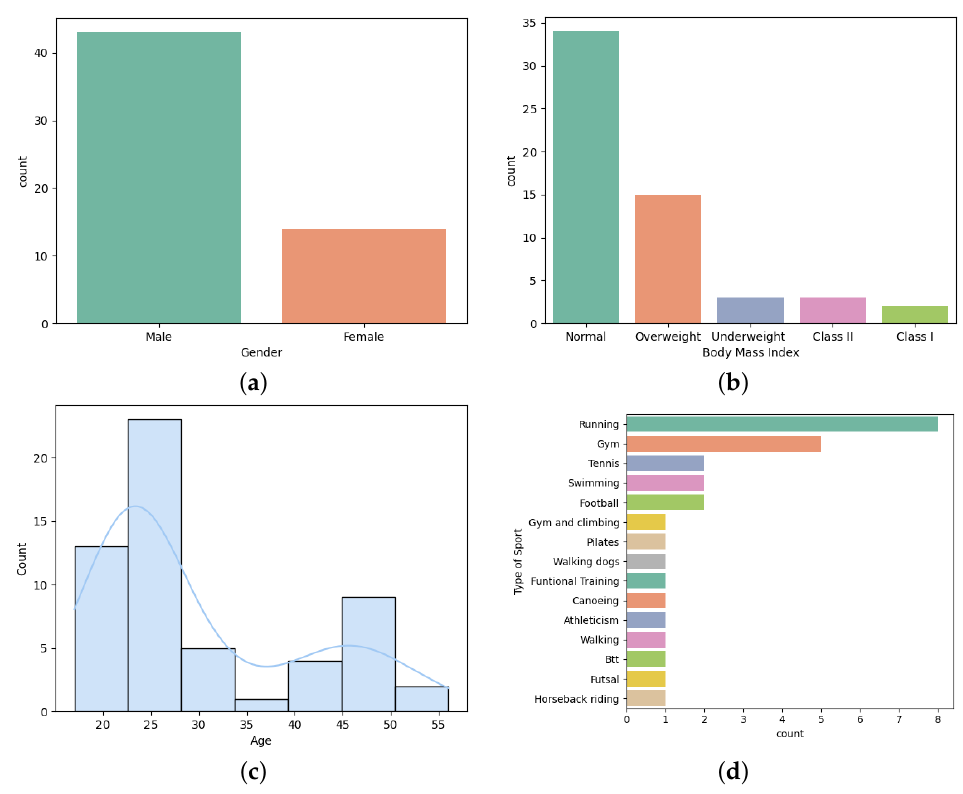
Figure 3. Personal information: ( a ) Gender. ( b ) Body mass index. ( c ) Age. ( d ) Type of sports.